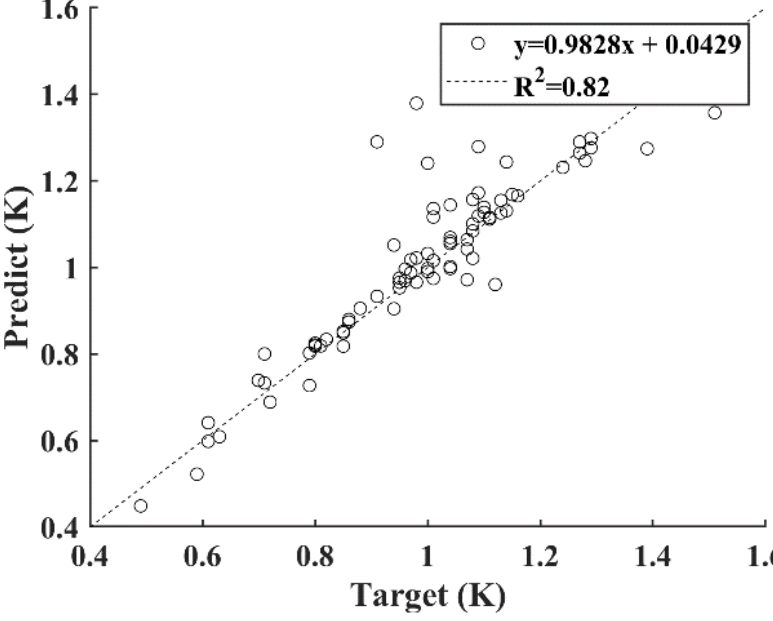
Figure 11. Comparison of target and prediction.